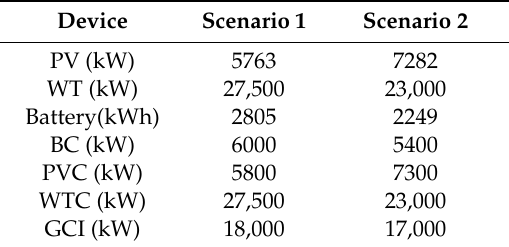
Table 6. Configuration results.